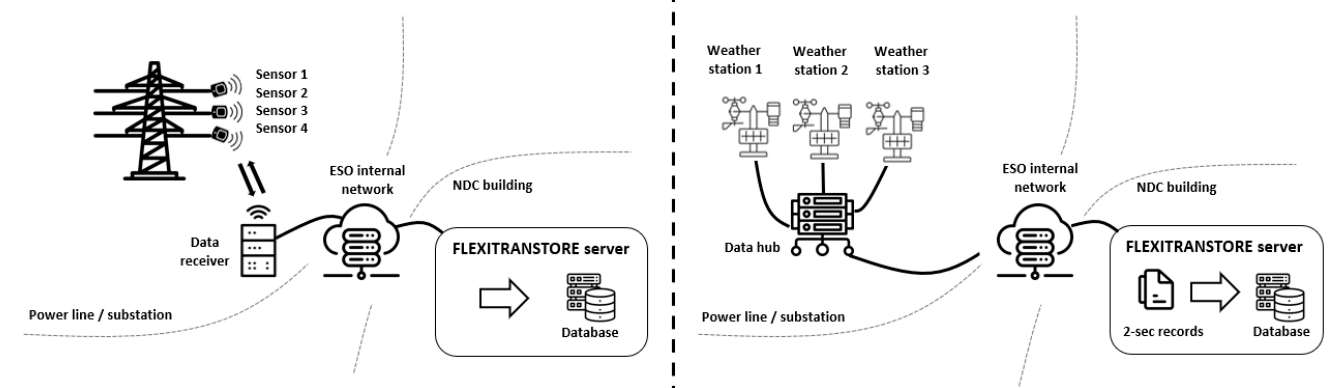
Figure 1. Schematic drawing of the hardware infrastructure applied in the project.